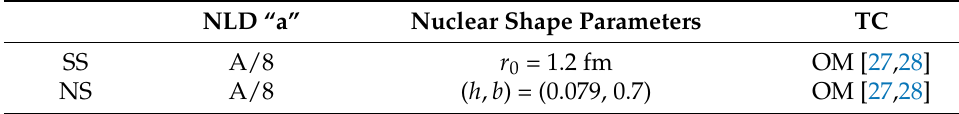
Table 1. Input parameters for the LILITA_N21